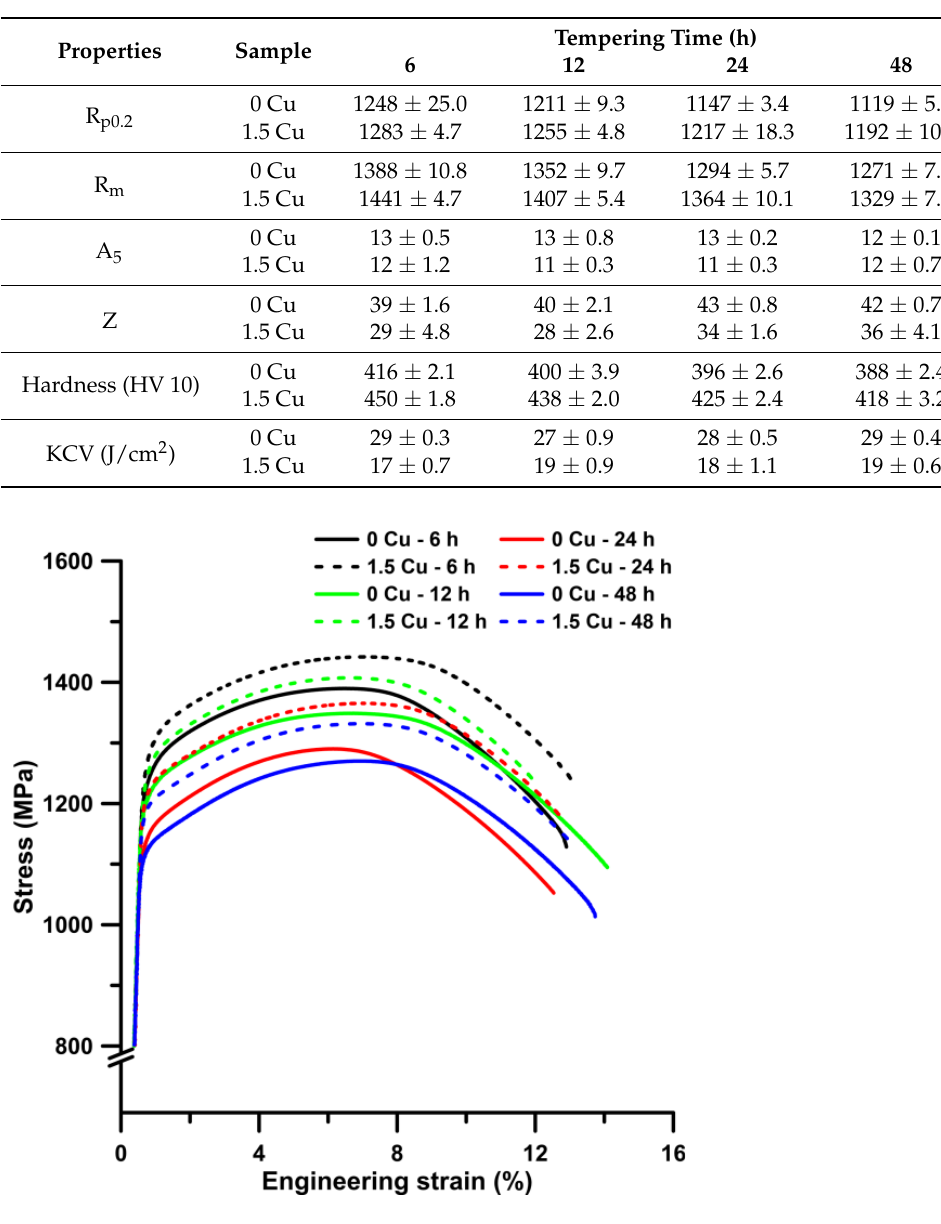
Figure 2. Tensile engineering stress — strain diagram for steels 0 Cu and 1.5 Cu tempered at 500 °C.